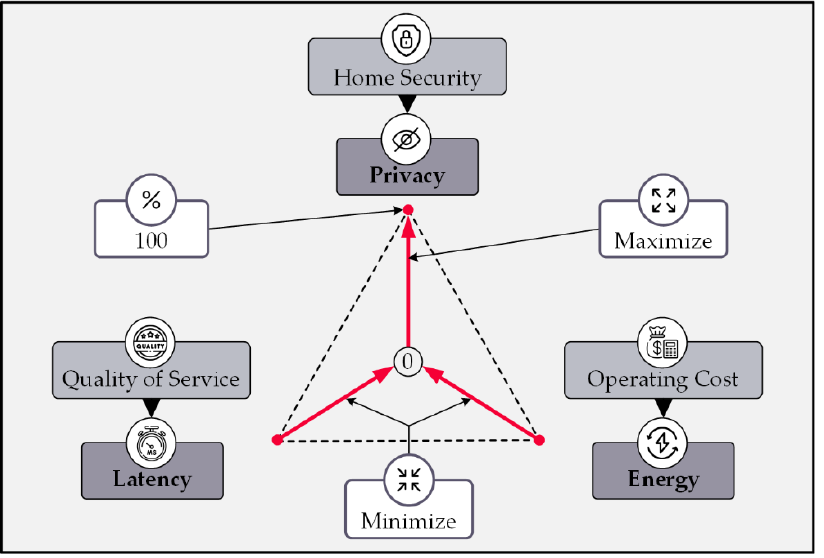
Figure 15. Triad of evaluation metrics for protection methods.